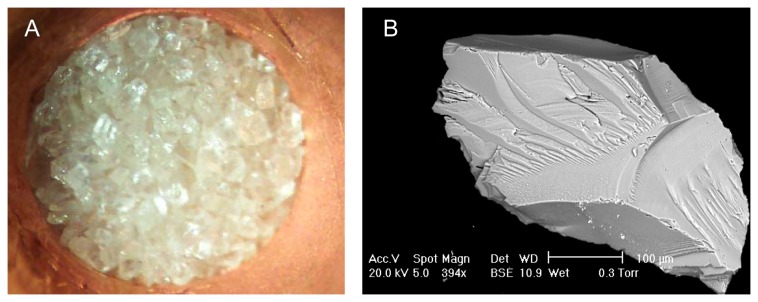
Sanidine minerals at Orgnac 3.(A) About 150 grains (200-300 μm) for a total fusion analysis. (B) Orgnac sanidine (SEM). The minerals are sharp-edged and unweathered.